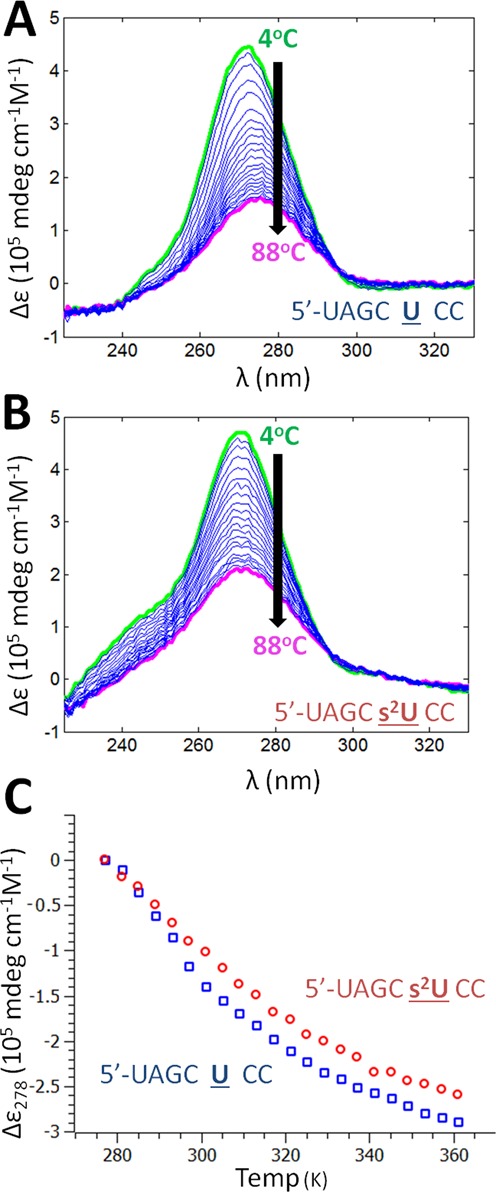
Circular dichroism studies of single-stranded RNA. (A) Overlapped spectra obtained by UV-CD spectroscopy of 5′-uagcUcc-3′ at temperatures ranging from 4°C to 88°C using 50 μM oligonucleotide in buffer containing 100 mM NaCl and 200 mM NaHEPES at pH 7.5; (B) The identical experiment performed using 5′-uagcs2Ucc-3′; (C) Normalized UV-CD signal of the s2U-containing ssRNA and its native counterpart at 278 nm.